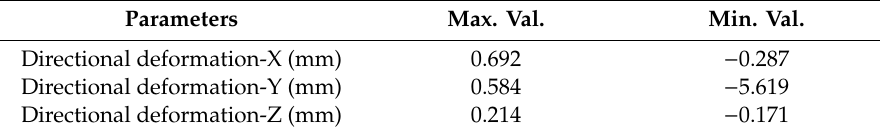
Table 4. Wing model bulk material directional deformation for 1% camber rate.